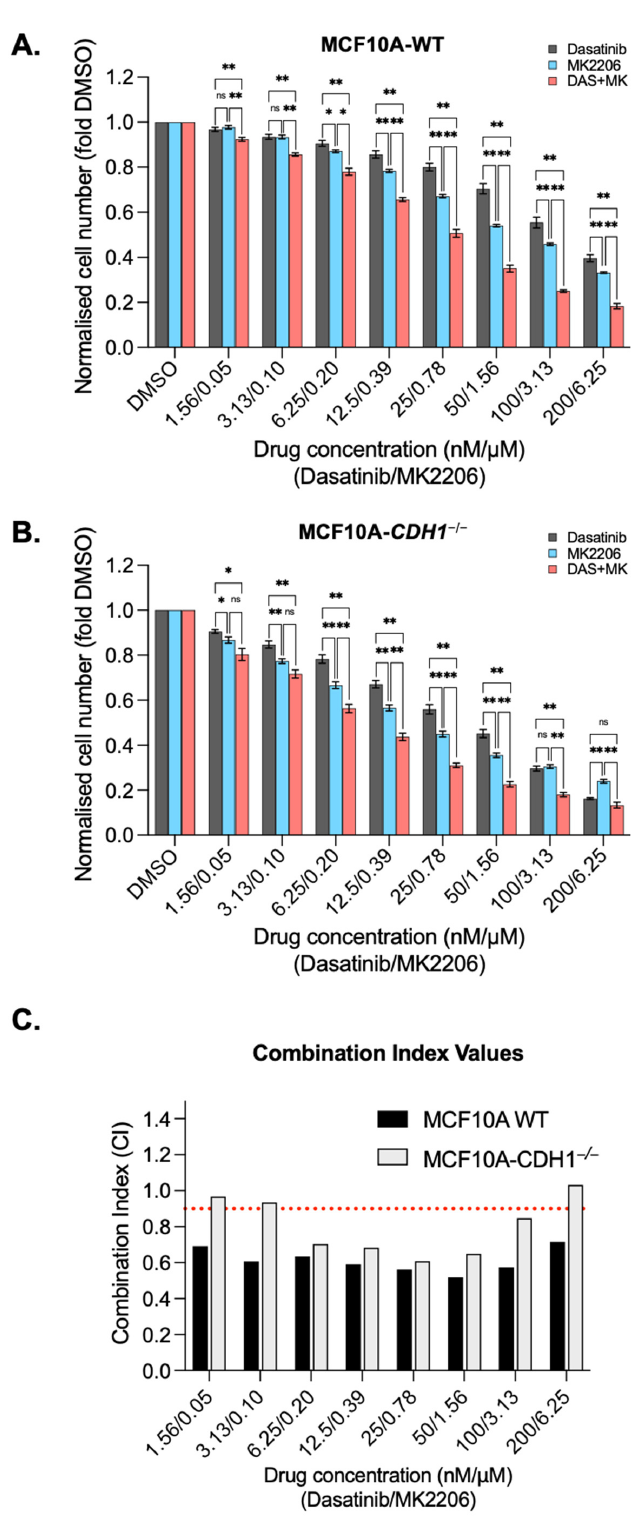
Figure 6. Combining dasatinib with the allosteric AKT inhibitor MK2206 is synergistic in MCF10A cells. Normalised MCF10A-WT ( A ) and CDH1 − / − ( B ) cell counts 48 h after treatment with serial dilutions of dasatinib, MK2206 or a combination of dasatinib and MK2206. ( C ) Combination index (CI) values for MCF10A-WT and CDH1 − / − cells treated with combination of dasatinib and MK2206. Values below 0.9 indicate the drug combination is synergistic at that concentration. For all graphs, error bars = SEM; ns: p > 0.05, * p < 0.05, ** p < 0.01; n ≥ 3 independent biological replicates; unpaired two-sided t